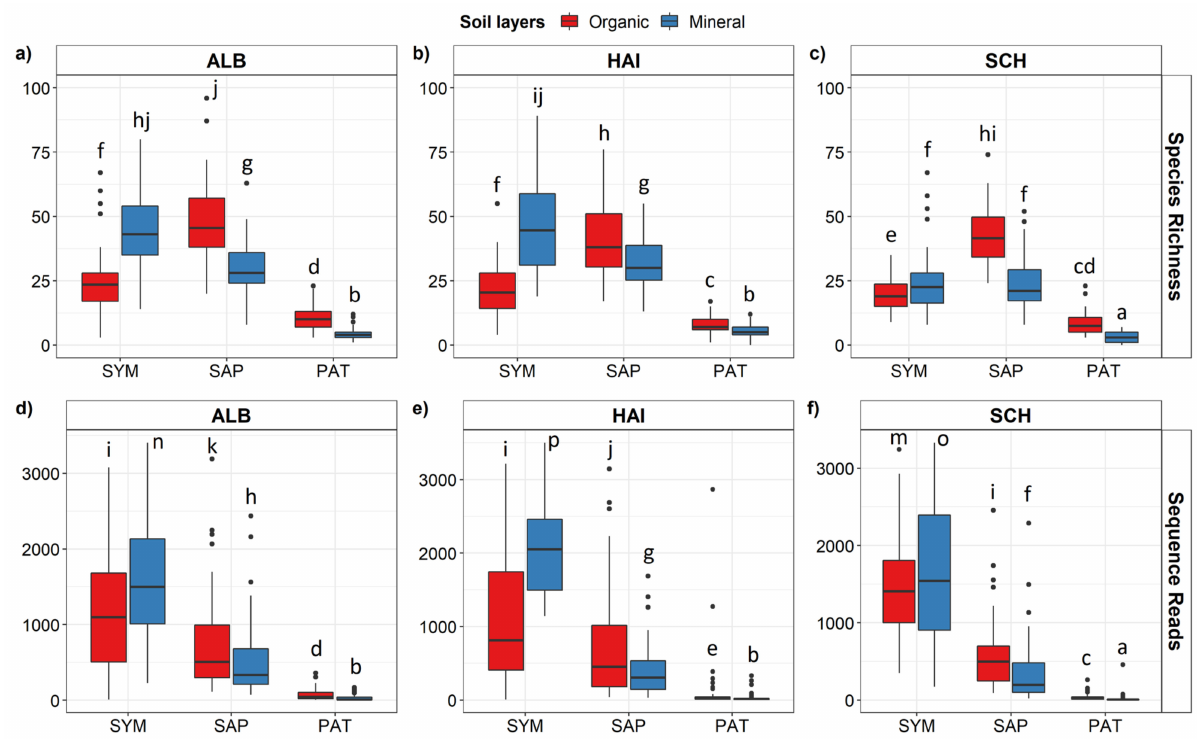
Figure 1. Species richness ( a–c ) and abundance ( d–f ) of root-associated fungi in the organic layer and mineral topsoil in three biogeographic regions. ALB = Schwäbische Alb, HAI = Hainich-Dün, SCH = Schorfheide-Chorin. SYM = Symbiotroph, SAP = Saprotroph and PAT = Pathotroph. Abundances are indicated as the number of sequences with a total number of 3890 sequences per sample. Data indicate means ± SE ( n = 50). Generalized linear model with Poisson regression and chi-square test was used to compare the fungal groups between soil layers. Pairwise differences of the functional groups of root-associated fungi between organic layer and mineral soil were compared using a post hoc test (HSD Tukey’s honestly significant difference). Different letters indicate significant differences of the means at p ≤